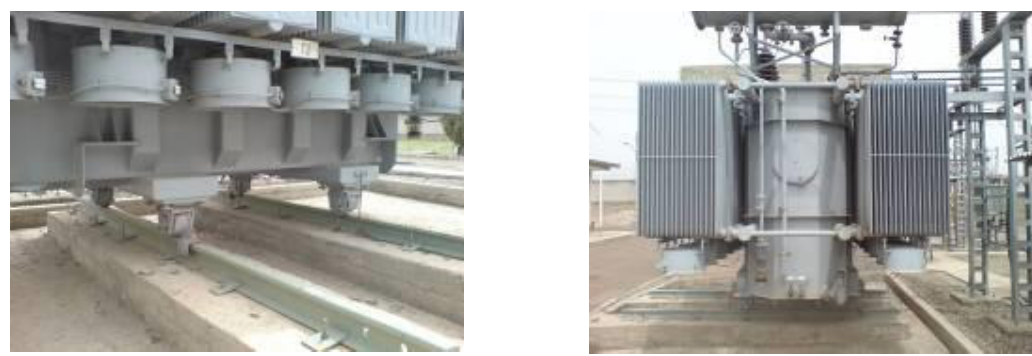
Figure 7. Power Transformer of 63 KV substation of